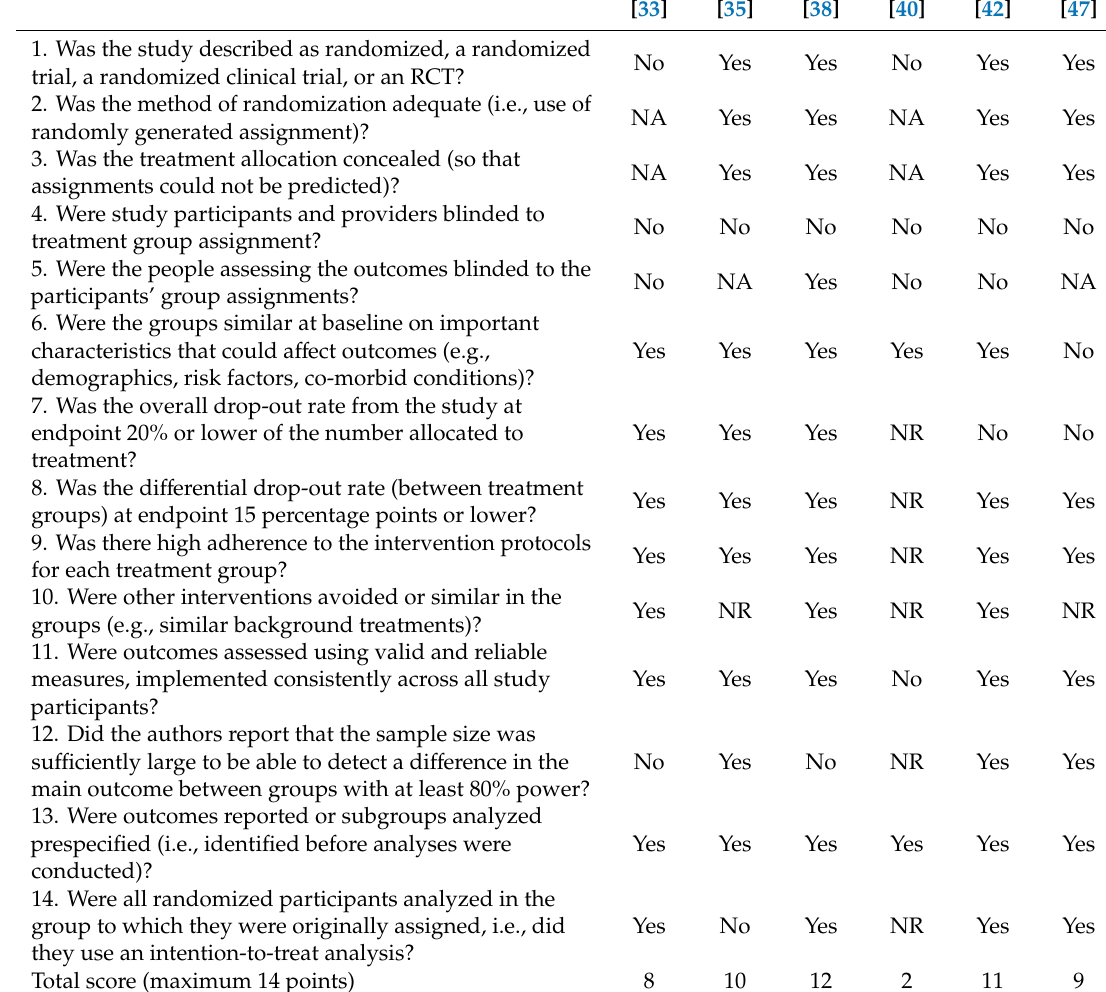
Table 7. Quality assessment of controlled intervention